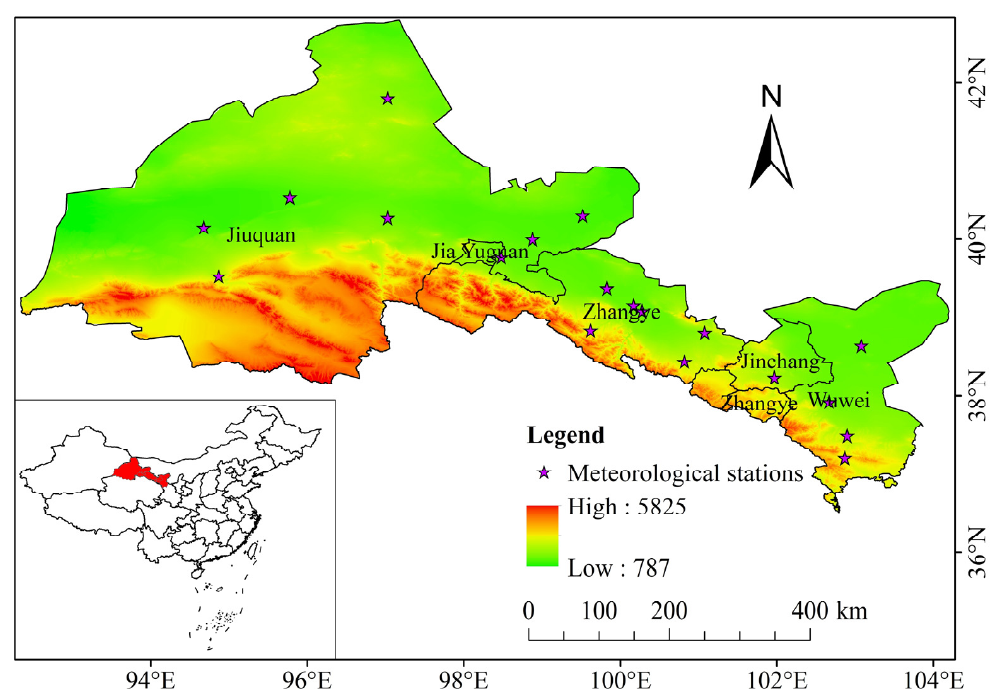
Figure 1. Location of meteorological stations and DEM information in the study area.